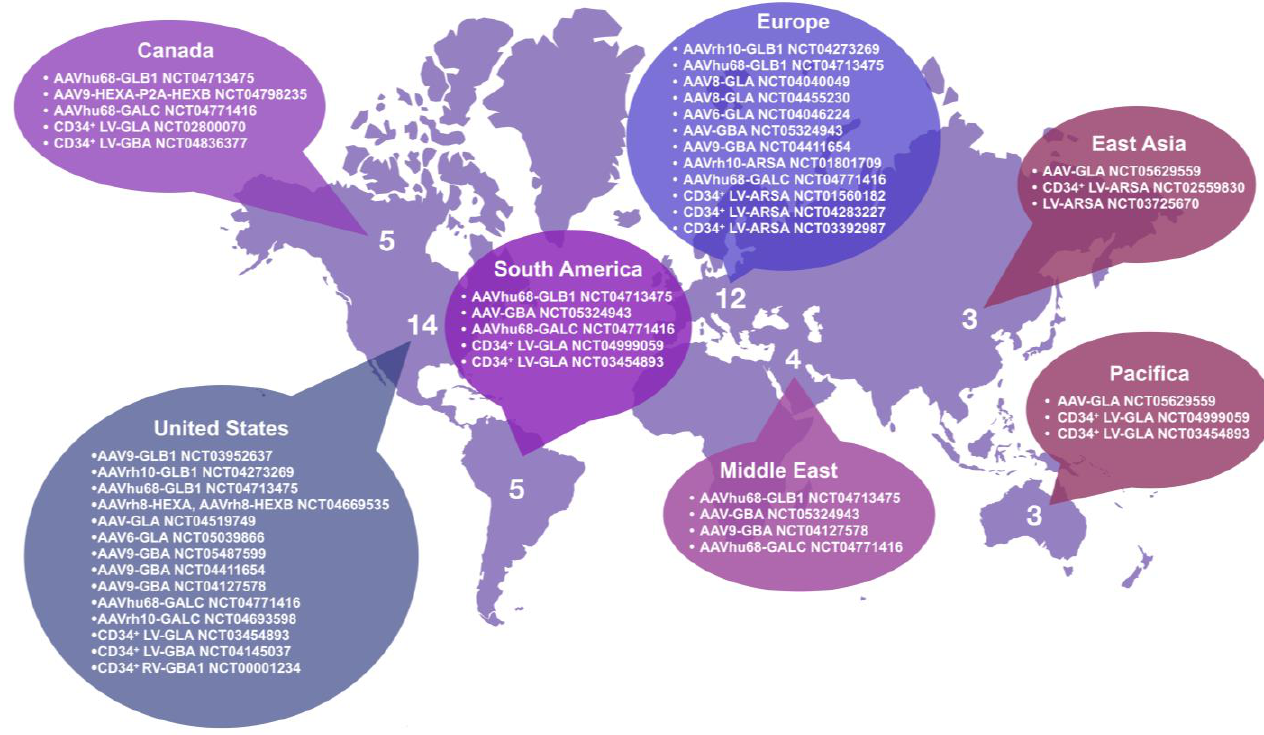
Figure 1. Localization of clinical trials for the treatment of sphingolipidoses. Studies with multiple locations are included in each region.